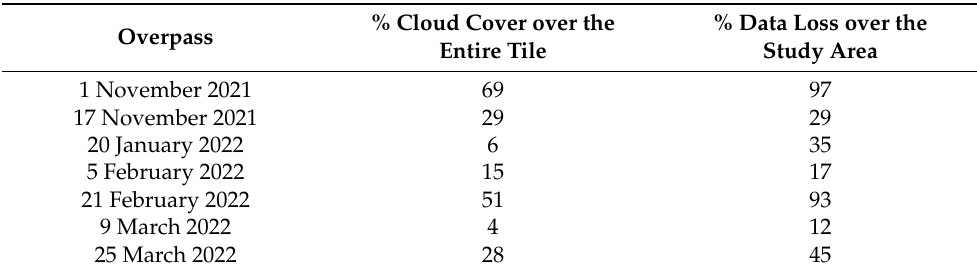
Table 5. Cloud cover and Landsat 8 OLI data loss caused by using the Quality Assessment (QA) band in the study area (Path/Row: 220/68). % Cloud Cover over the % Data Loss over the Overpass Entire Tile Study Area